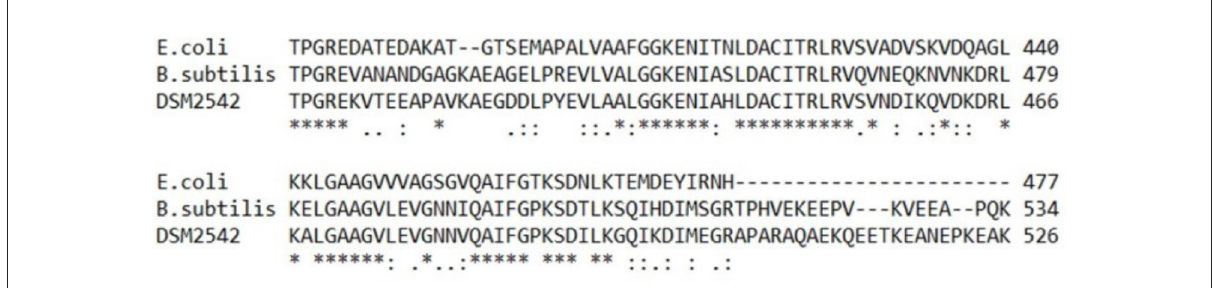
FIGURE12 Amino acid sequence alignment of E. coli K-12, B. subtilis 168 and P. thermoglucosidasius DSM 2542 using UniProt Clustal Omega program. Regions around conserved sequence DACITRLR in PtsG are compared. * Indicates positions contain fully conserved residues,: indicates strongly similar properties, while. indicates weakly similar